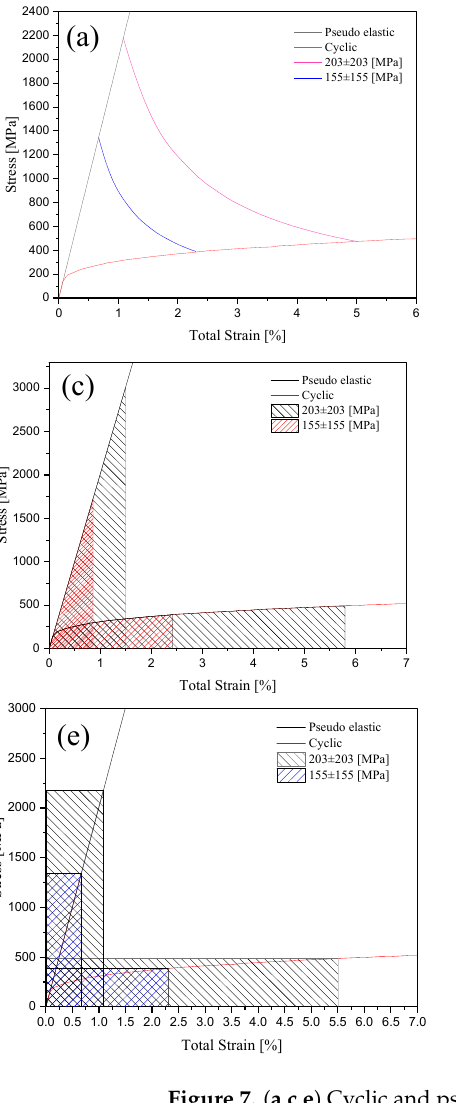
Figure 7. ( a , c , e ) Cyclic and pseudo–elastic curves for steel specimens with D = 9 mm notch diameter subjected to different loading values using H-S, Glinka and Neuber models. ( b , d , f ) cyclic and pseudo–elastic curves for a steel specimen undergoing 155 ± 155 MPa for notched specimens with D = 9 and D = 15 mm notch diameters using the H-S, Glinka, and Neuber models.